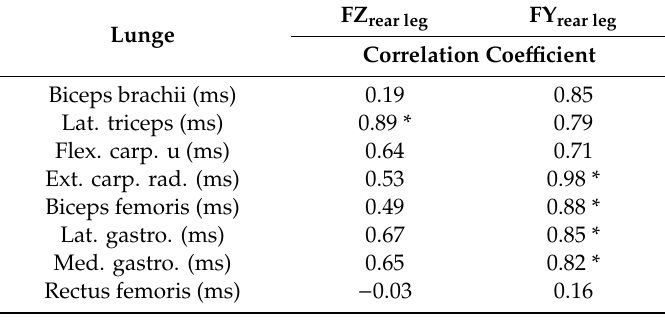
Table 5. Correlation coe ffi cients of the mean values of the times until the peak EMG signal was recorded for the vertical (FZ) and horizontal components (FY) of the signal recorded during a touch executed with a